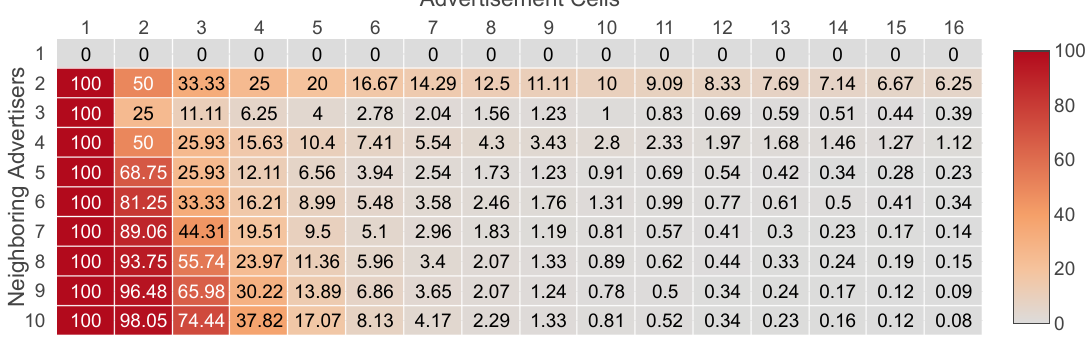
Figure 3. Full collision probability (%) between the neighboring EB transmissions of a joining node, when each advertiser transmits in a randomly selected advertisement